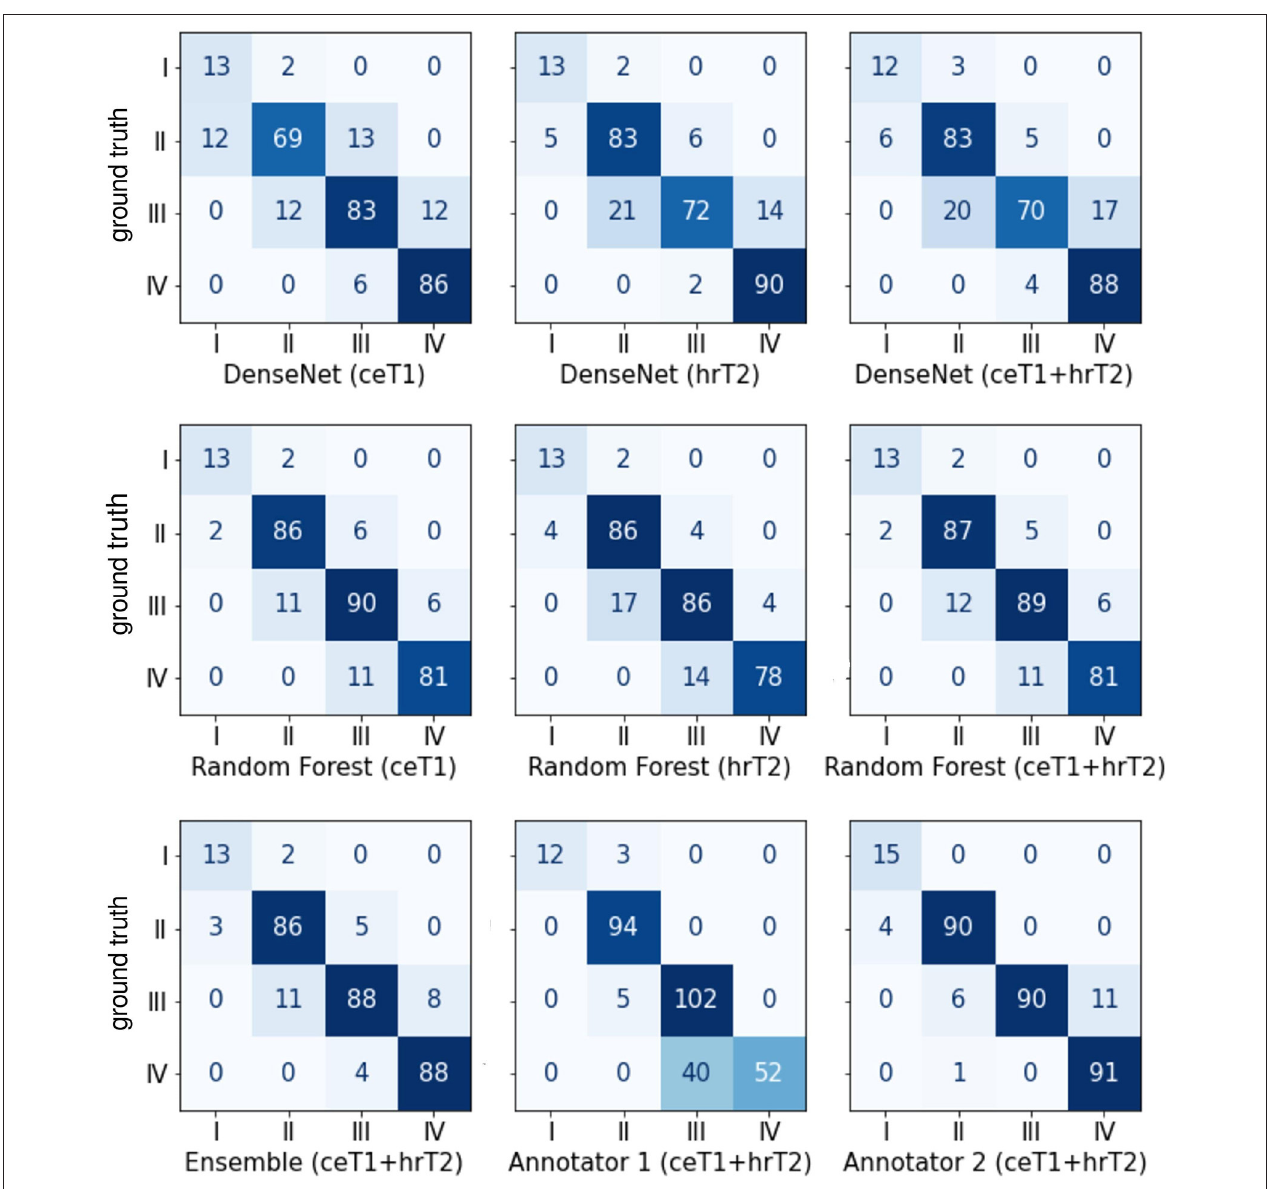
FIGURE 4 | Confusion matrices between the ground truth Koos grades on the horizonal axis and automatic or human Koos grade predictions on the vertical